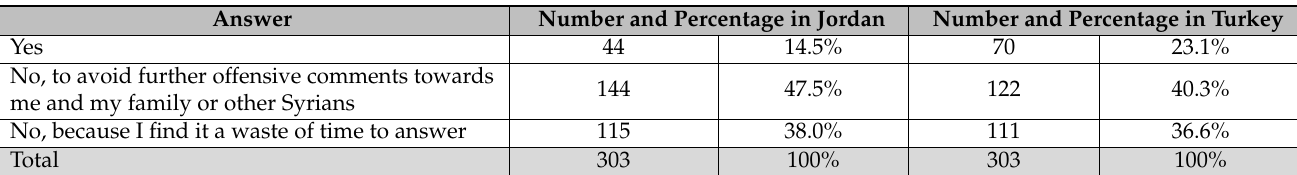
Table 6. If the Respondents when Encountered or would Encounter Offensive or Derogatory State- ments, Photos, News, or Comments Towards Syrian Refugees in General on Social Media will Respond, Defend or Make